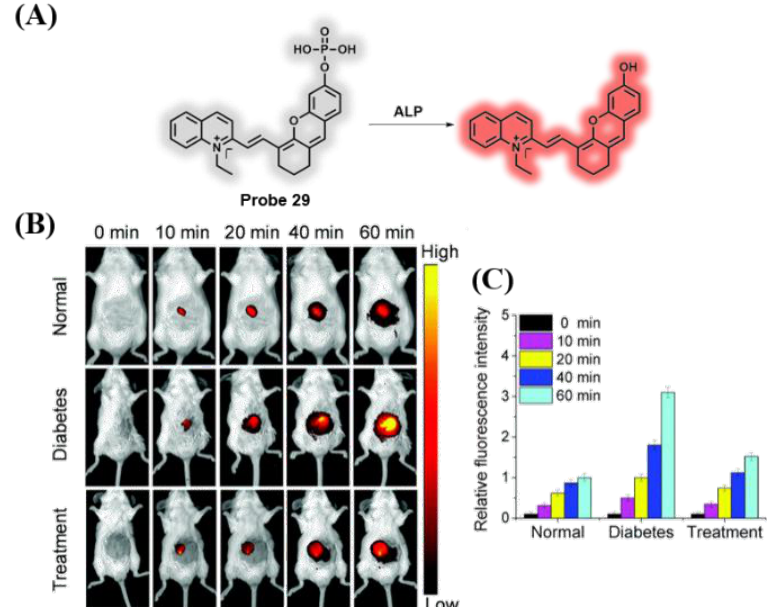
Figure 24. ( A ) Imaging mechanism of probe 29 ; ( B ) fluorescence images of mice from the normal group, diabetes group, and treatment group after injection of probe 29 over time; ( C ) relative fluorescence intensity in ( B ). Conditions: λ ex = 640 nm, λ em = 680 – 780 nm. Adapted from Reference [119].